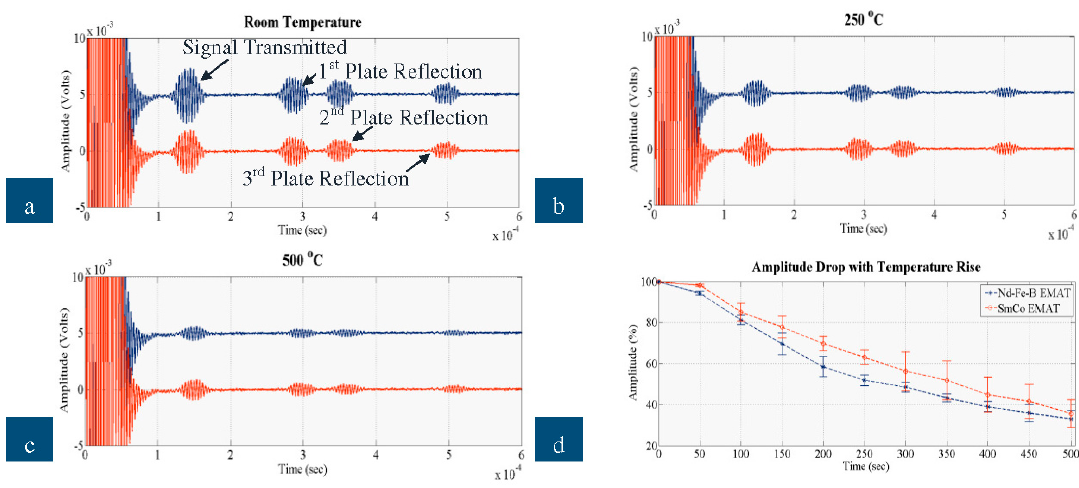
Figure 10. Signal received by Nd-F-B and SmCo EMAT on steel at ( a ) room temperature; ( b ) 250 °C; ( c ) 500 °C; ( d ) amplitude drop against temperature rise.